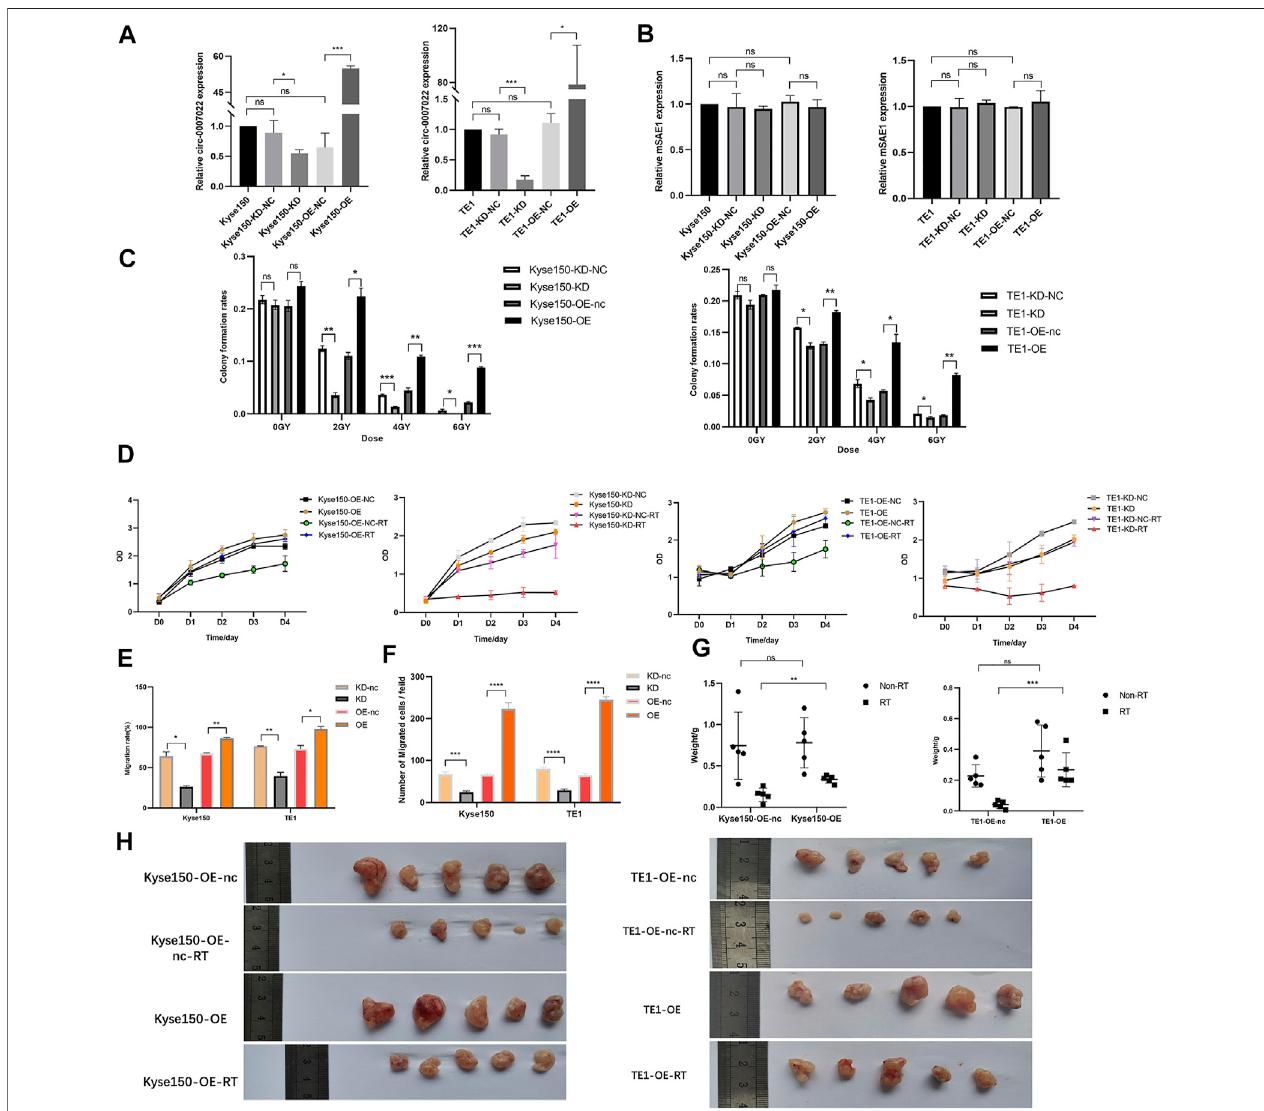
FIGURE 3 | Circ-0007022 reduced radiosensitivity of ESCC cells in vitro and in vivo . (A,B) The qRT-PCR indicated expression levels of circ-0007022 and mSAE1 expressioninKyse150andTE1cellsaftertransfectionoftheoverexpressionorknockdownplasmids. (C,D) CloneformationandCCK-8assaysrevealedtheproliferation capabilities of Kyse150 and TE1 cells transfected with the overexpression or knockdown plasmids after radiotherapy. (E,F) Wound healing and transwell assays assessed cell migration abilities of Kyse150 and TE1 cells, transfected with the overexpression or knockdown plasmids, after radiotherapy. (G,H) BALB/C nude miceweretreatedinjectedwithKyse150/TE1cellswithtransfectionofoverexpressionplasmidsorcorrespondingnegativecontrolandreceivedradiationtherapy.Tumor wight were detected in each group. Data are expressed as mean ± SD, ns > 0.05, * p < 0.05, ** p < 0.01, *** p < 0.001, **** p < 0.0001.